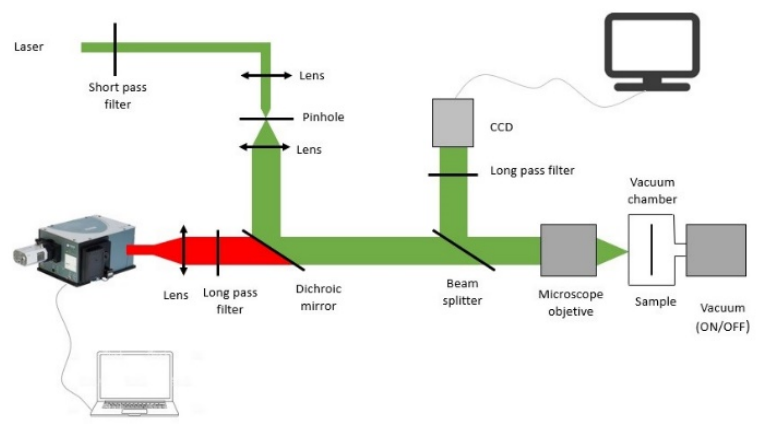
Figure 1. Modified confocal microscope setup used to observe the WGM.